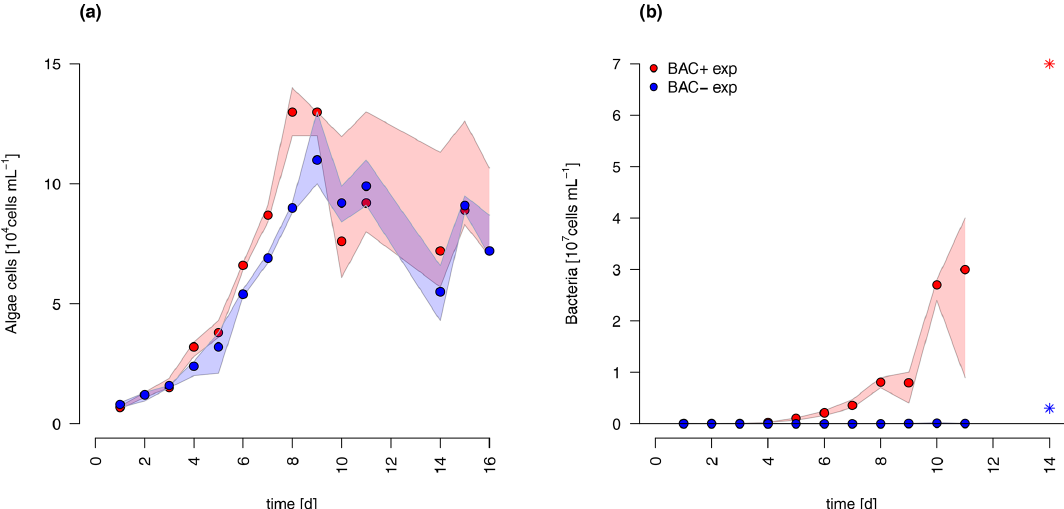
Figure 3. Abundances of (a) Chaetoceros socialis and (b) bacteria over the 14d experimental period. Blue data are from BAC − cultures and red from BAC + cultures. The asterisks at day 14 indicate potential outliers as based on only one replicate. Circles represent median values (blue = BAC − , red = BAC + ) and the colored polygons show maximum and minimum of measured data ( n = 1–3, Table S2, not visible for bacteria counts in BAC − cultures due to very small range). The maximum values of the BAC + experiment include algae cells in the biofilm (after day